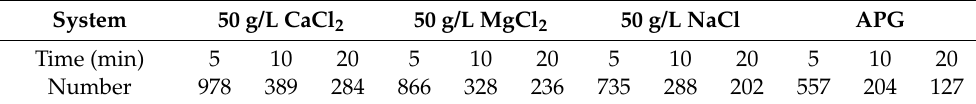
Table 1. Variation of the number of foams in different cationic systems with